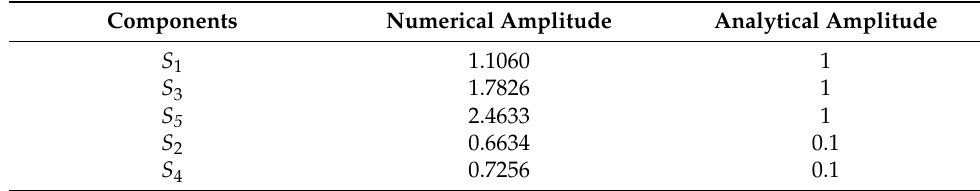
Table 2. Maxima of numerical and analytical rogue waves with time starting at t 1,0 = − 3.